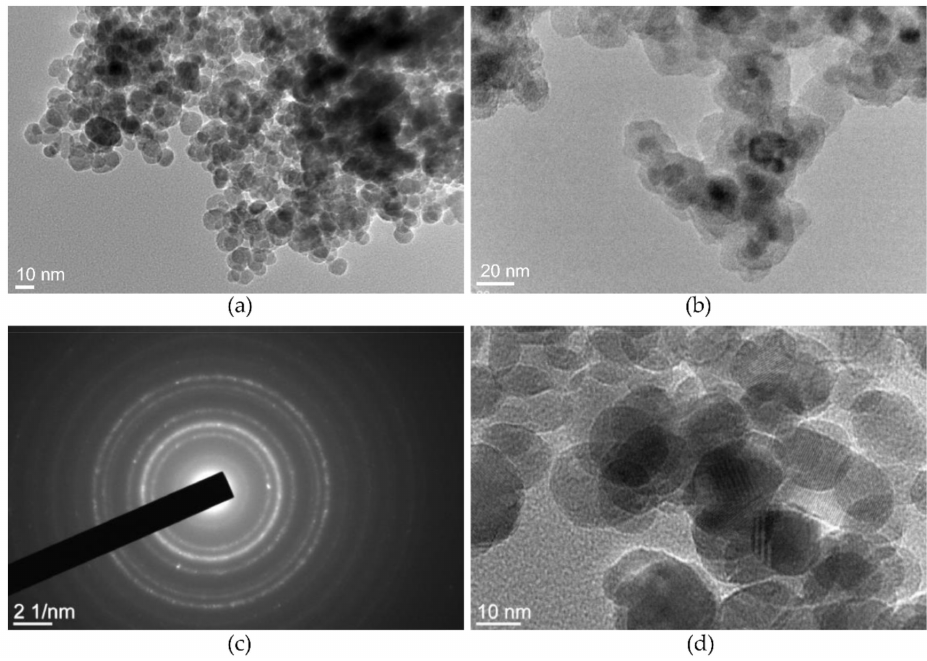
Figure 5. TEM of γ -Fe 2 O 3 NPs ( a ), γ -Fe 2 O 3 -NH 4 OH@SiO 2 (APTMS) NPs ( b ), the electron di ff raction pattern of γ -Fe 2 O 3 NPs ( c ), the spinel structure of γ -Fe 2 O 3 NPs ( d ).